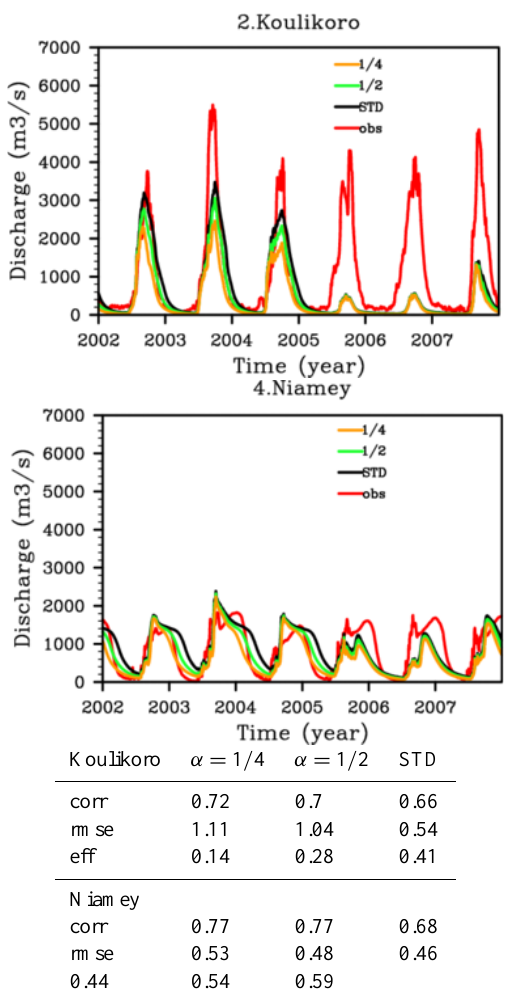
Fig. 17. Impact of aquifer distribution factor α on the discharge (TRMM is used as forcing). The standard run stands for the simu- lation AQ-F with standard parameters (used for the simulations in previous